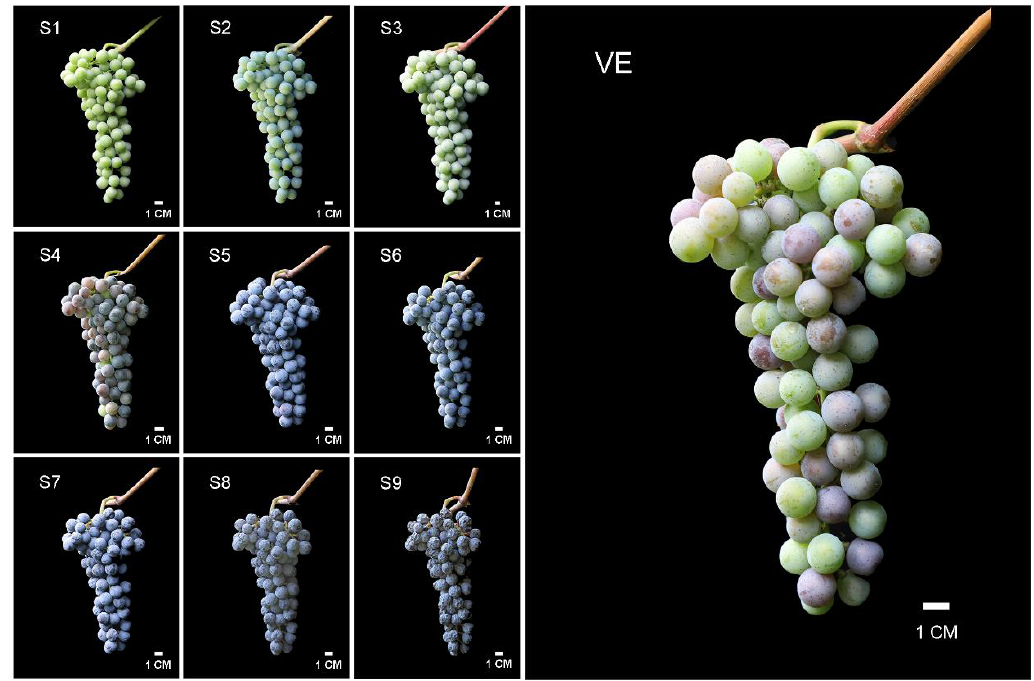
Figure A1. Photos of ‘Beihong’ were taken during sampling time in 2019. S1–S9 represent the sam- pling date in 2019, and bar = 1 cm.